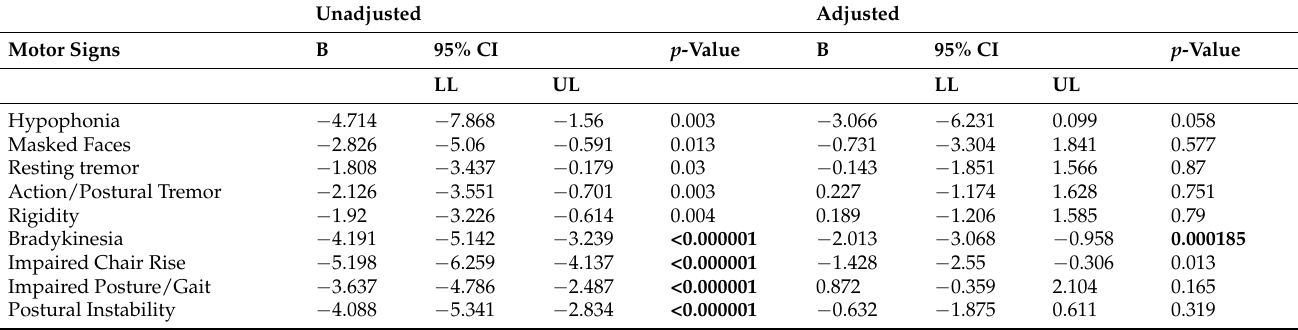
Table 3. Linear regression analysis for association between motor signs and language.